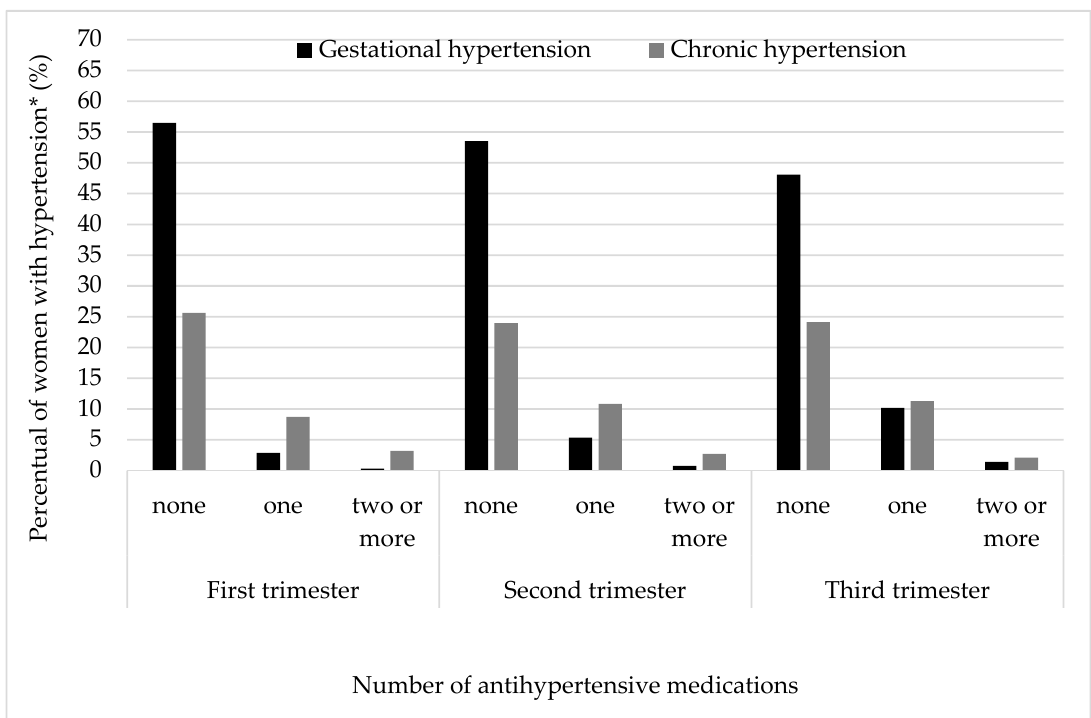
Figure 2. Number of cardiovascular medications taken by trimester by women with gestational and chronic hypertension ( n = 1285). 2015 Pelotas birth cohort. * Missing or ignored on medication use n = 51.